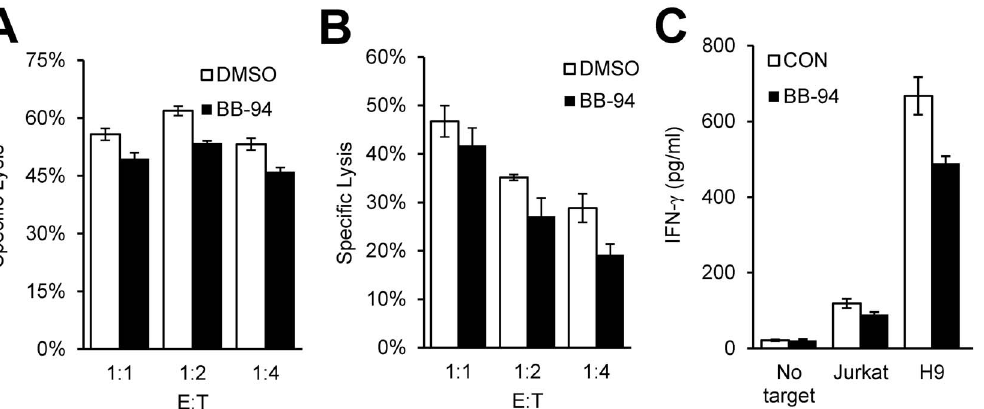
Figure 8. The role of shedding of ULBP2 in NK cell-mediated effector functions. (A, B) NK cell-mediated cytolysis in the presence of BB-94. Jurkat (A) and H9 (B) cells were used as target cells for cytotoxicity assay with IL-2 expanded primary human NK cells at the indicated E:T ratios. (C) The presence of BB-94 reduced IFN- c production by NK cells. 10 5 the indicated target cells were incubated with equal number of IL-2 expanded peripheral blood NK cells at 37 u C for 6 hours. The concentration of IFN- c in supernatants was determined by ELISA. Figure S1 NK cell-mediated loss of ULBP2. Jurkat cells were incubated with 10 5 IL-2 expanded peripheral blood NK cells at the indicated E:T ratios at 37 u C for 2 hours. The resulting cell mixtures were stained by PE-conjugated mouse anti-human